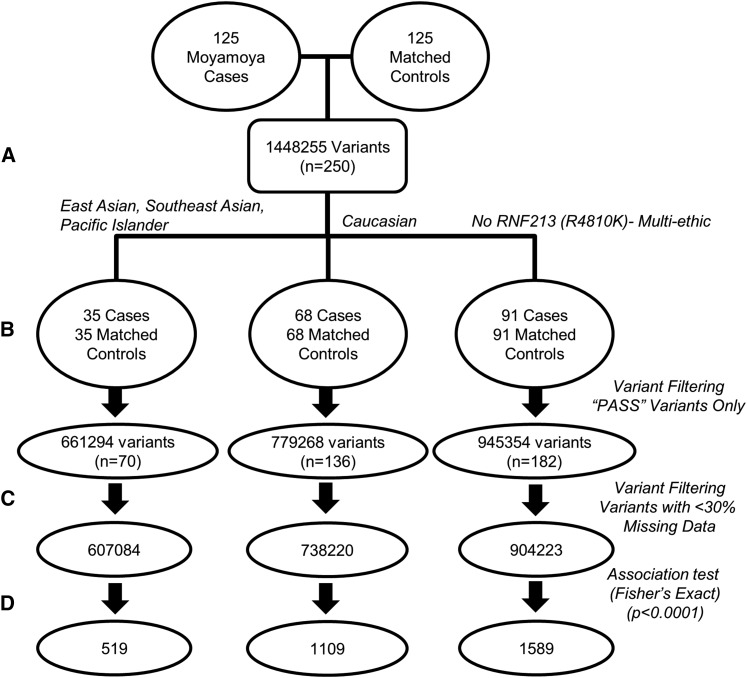
Case-control workflow for variant discovery. There were 125 MMD cases individually matched based on ethnicity and sex to 125 subject samples drawn from the Personalis Controls Library. Samples were analyzed in a stepwise process of exome sequencing, variant alignment and detection, and variant annotation to obtain 1,448,255 variants across 250 samples (A). This sample set was subdivided to construct three case-control datasets based on ethnicity (East Asian/Southeast Asian/Pacific Islander; Caucasian) and on the lack of the RNF213 founder variant (B). In each of these case-control datasets, variants were filtered to include only those with adequate call quality and excluded those with >30% missing data across samples (C). These variant sets were used to create a list of enriched variants (P < 0.0001) for each case-control study assuming an additive model (D).